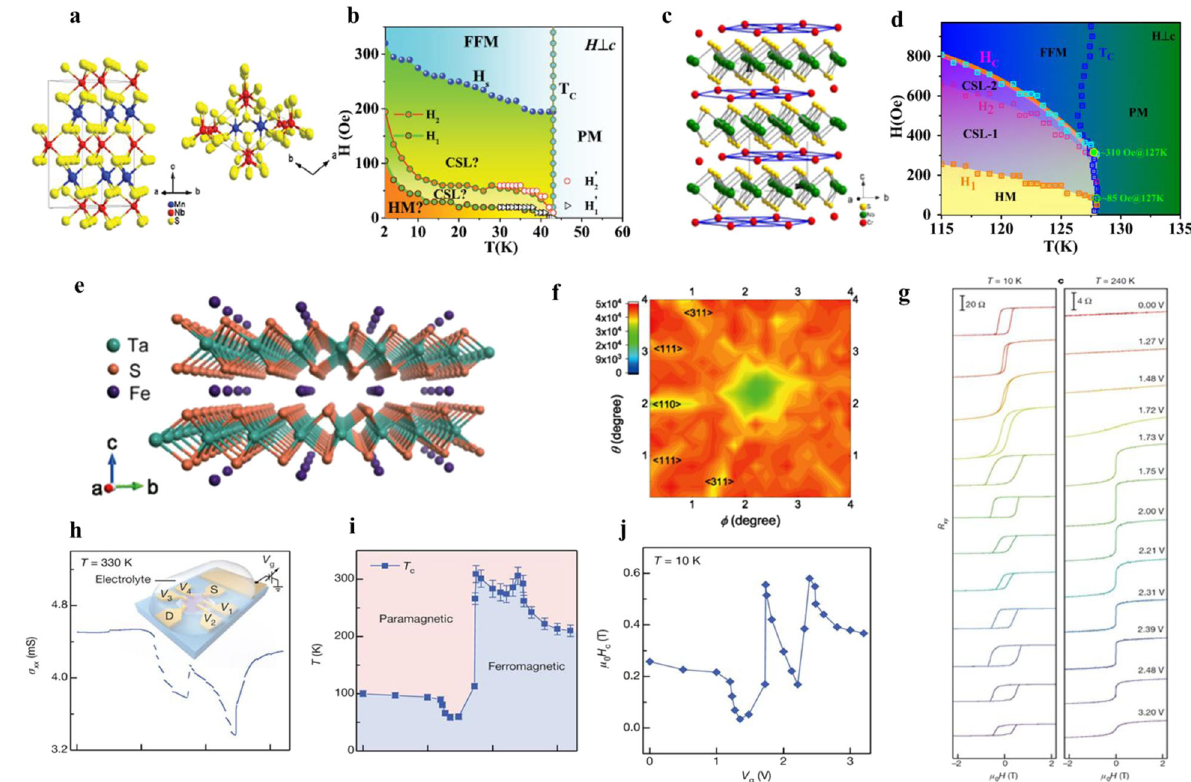
Fig. 6 Intercalation effects on the magnetism. a Crystal structure of MnNb 3 S 6 . b H -T phase diagram in the vicinity of the phase transition for MnNb 3 S 6 with H ⊥ c (HM corresponds to possible helimagnetism; CSL denotes possible chiral magnetic soliton phase; PM is paramagnetic state; and FMM represents forced ferromagnetic state) 173 . c The crystal structure of Cr 1 / 3 NbS 2 . d The H-T phase diagram in the vicinity of the phase transition obtained by the scaling of M-T-H for Cr 1/3 NbS 2 with H ⊥ c (HM corresponds to the helimagnetism; CSL is the chiral magnetic soliton phase; PM is the paramagnetic state; and FMM represents the forced ferromagnetic state) 174 . e Schematic diagram of Fe 1/4 TaS 2 crystal structure. Ta, S, and Fe atoms are denoted by green, orange, and purple balls, respectively. f Experimental two-dimensional backscattered- yield mapping patterns of the Fe in the crystal obtained from RBS/C spectra. θ and φ are the scanning angles when performing the two- dimensional mapping, and the color scale is the integral backscattering signals (counts) 175 . Ferromagnetism in an atomically thin Fe 3-x GeTe 2 fl ake modulated by an ionic gate. Conductance as a function of gate voltage V g measured in a trilayer Fe 3-x GeTe 2 device at g 10 K and 240 K, h 330 K. i Phase diagram of the trilayer FGT sample as the gate voltage and temperature are varied. j Coercive fi eld as a function of the gate voltage at T = 10 K 105 . Panels a , b republished with permission of IOP Publishing from Critical phenomenon and phase diagram of Mn- intercalated layered MnNb 3 S 6 . Dai et al., vol. 31. Copyright (2019); permission conveyed through Copyright Clearance Center, Inc.; panels c , d reused with permission from American Physical Society/Han et al. 174 (https://doi.org/10.1103/PhysRevB.96.094439); panels e , f reused with permission from American Physical Society/Zhang et al. 175 (https://doi.org/10.1103/PhysRevB.96.054406); panels g – j reprinted with permission from Springer Nature Publications Nature 105 , Copyright (2018), advance online publication 07 August 2018 (https://doi.org/10.1038/s41586- 018-0626-9, Nature